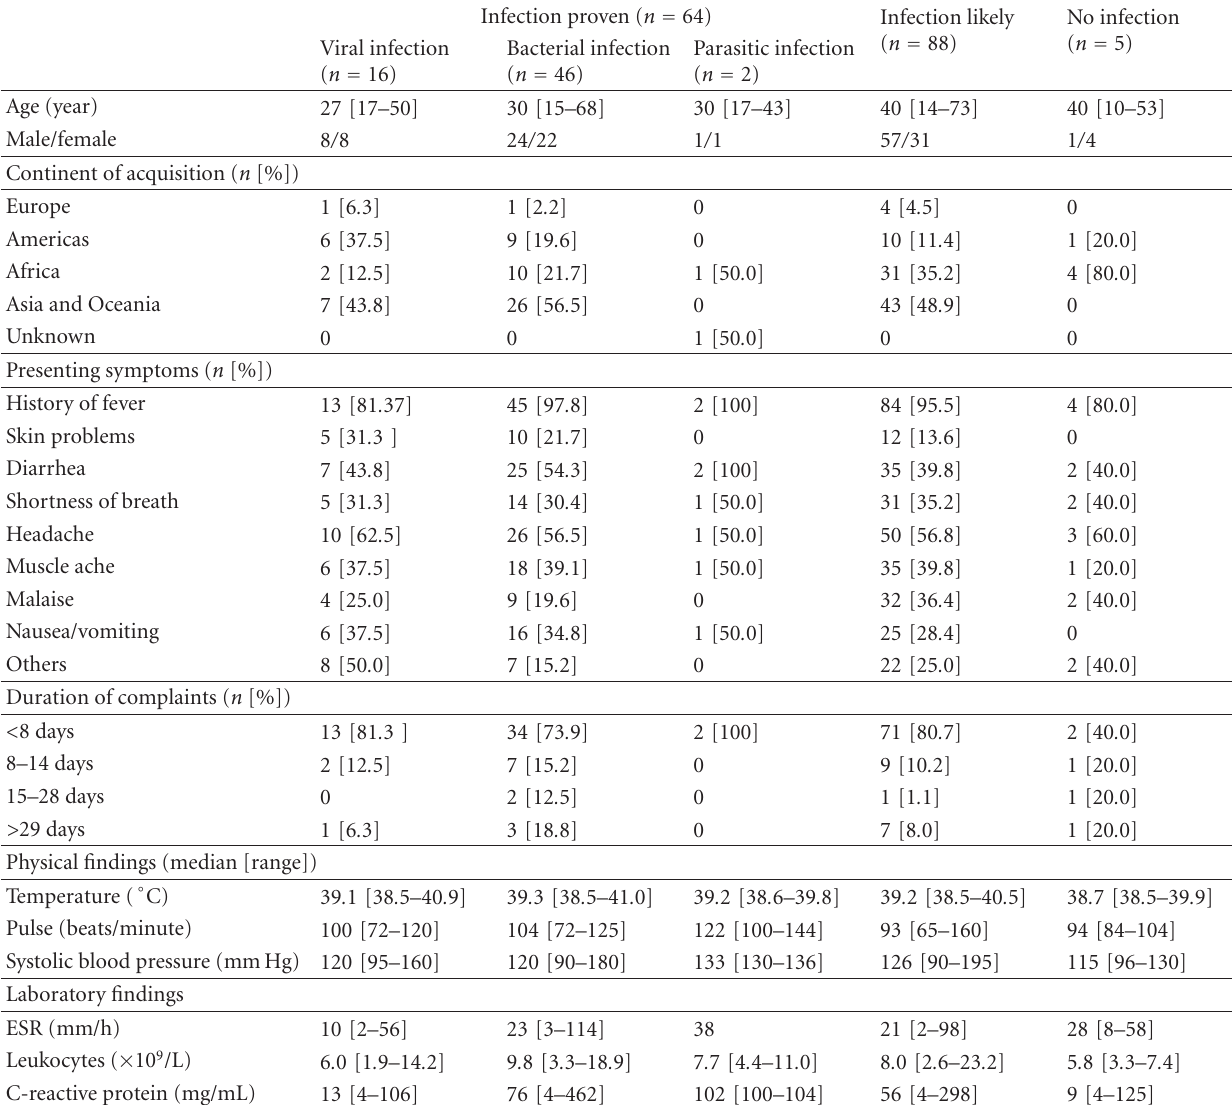
Table 1: General and laboratory characteristics of the travellers with fever on admission, specified by outcome and class of causative micro- organism. Data are given as median